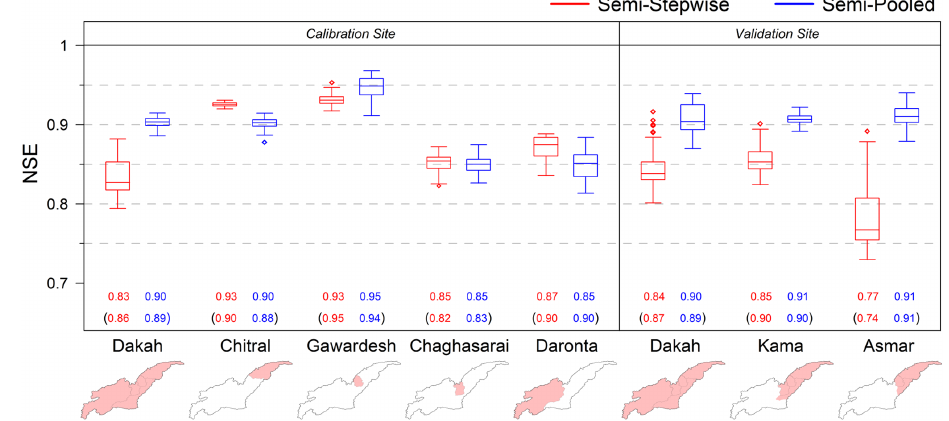
Figure 6. Comparison of the stepwise and pooled calibrations under the semi-distributed parameterization. Each calibration is conducted 50 times. Values on the bottom represent expected values of NSE (in upper row) and KGE (within parenthesis in lower row) from 50 calibrations.